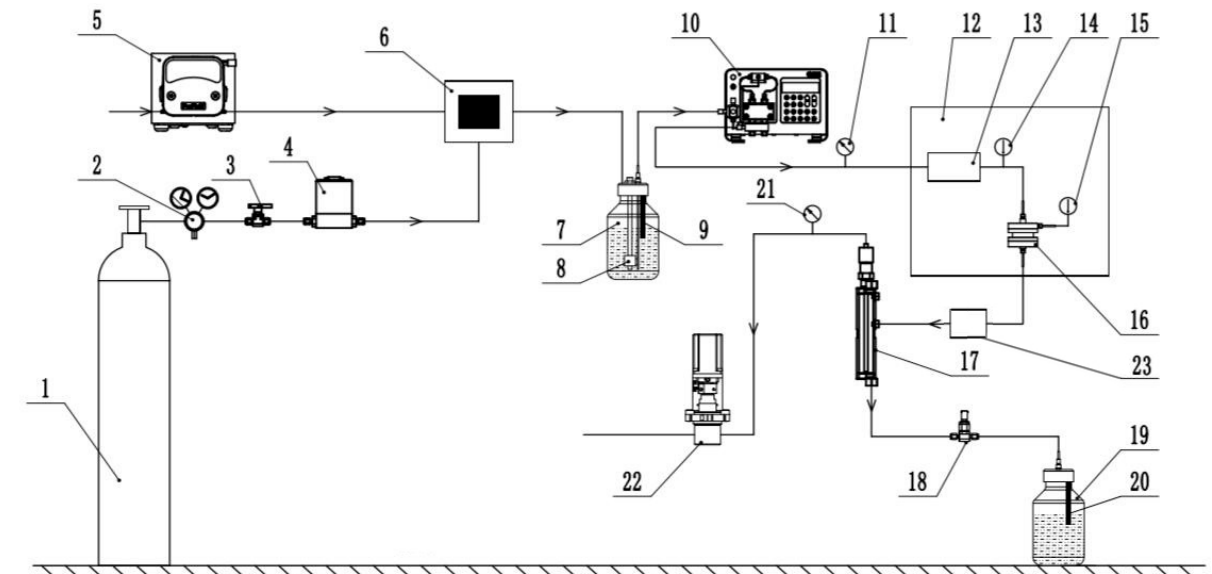
Figure 6. Flow chart of the dissolution test.